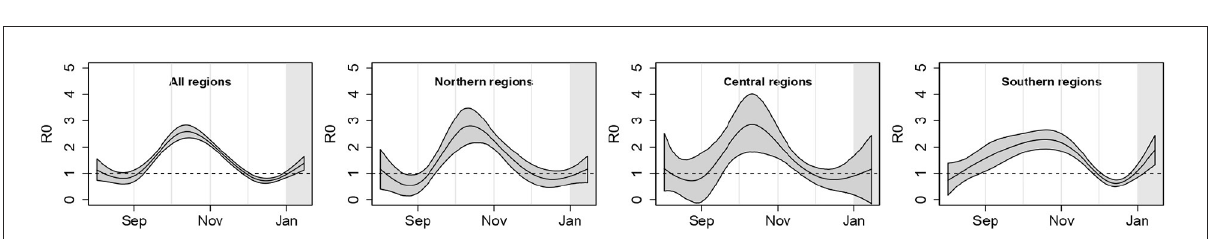
FIGURE2 Posterior mean of the meta-analytic curves of R 0 ( t ) with point-wise 90 % credible bands for the entire country and by geographical area; p = 1.15 % , T = 14 days.